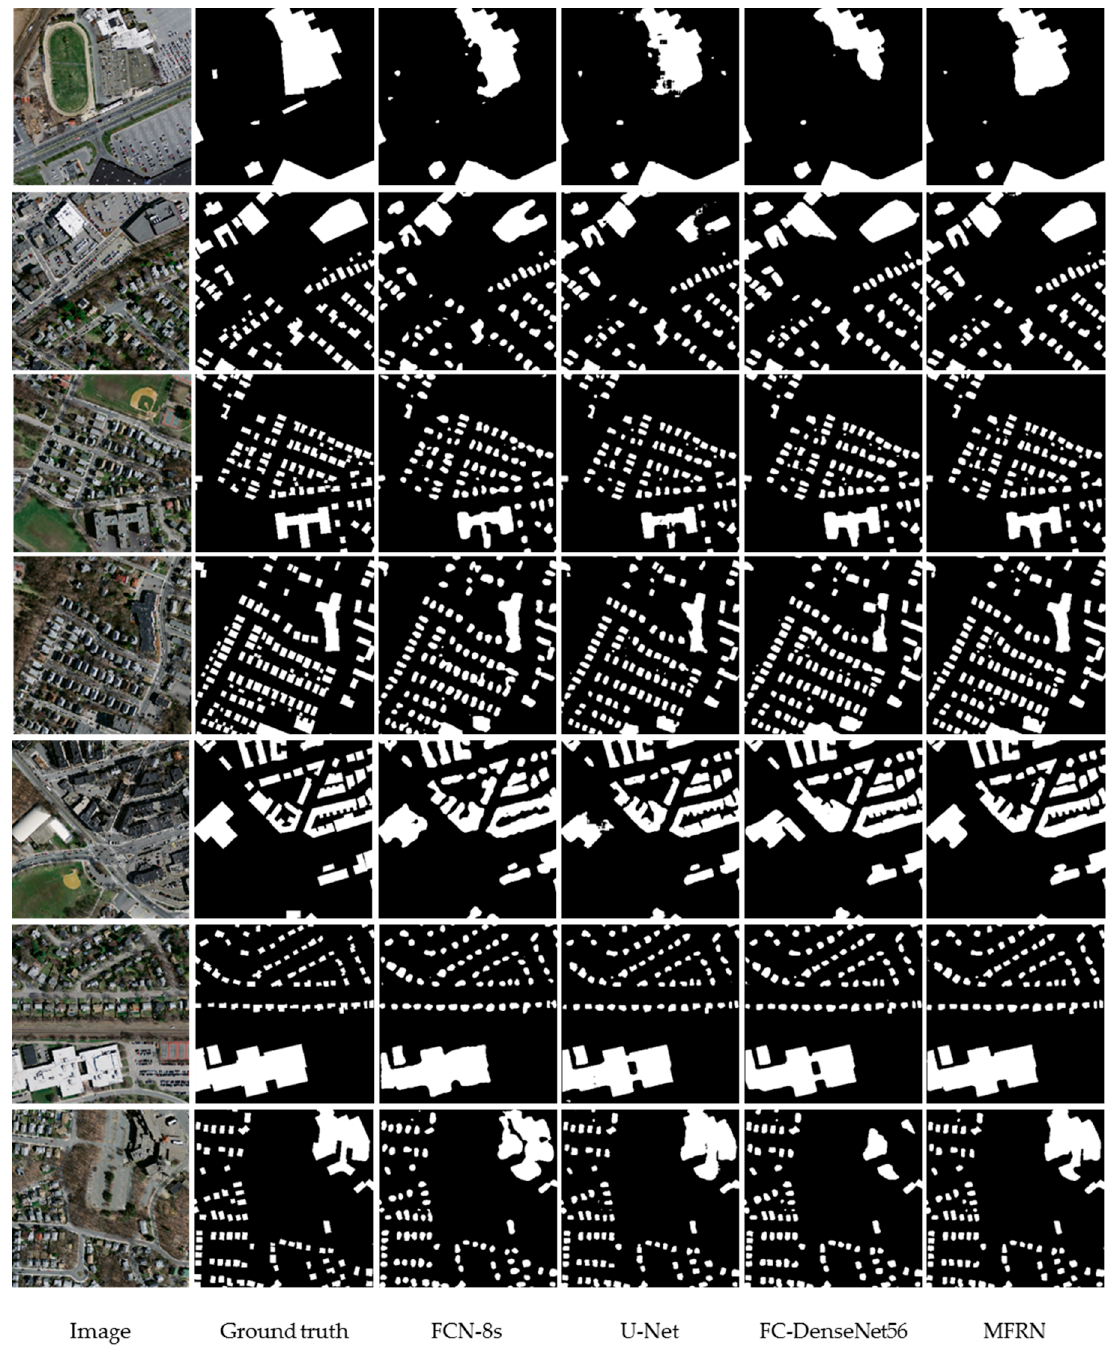
Figure 7. Segmented patches from FCN-8s, U-Net, fully convolutional DenseNets and MFRN. The white color in the segmented patches represents pixels belonging to buildings.